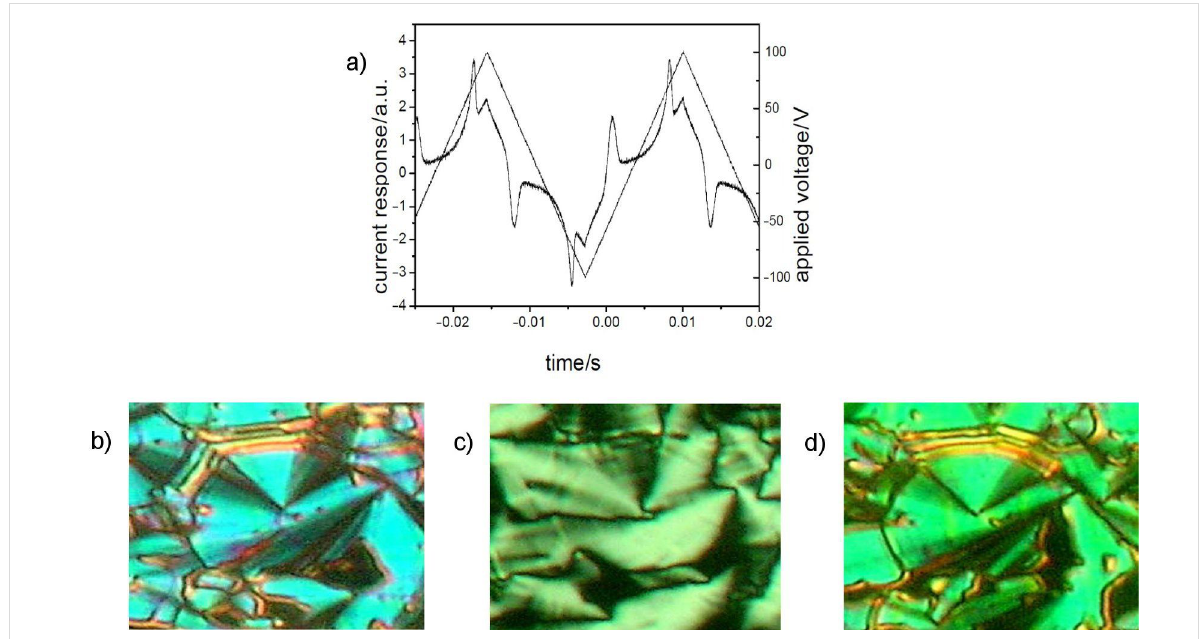
Figure 25: Electro-optical behaviour of compound OH 6c : a) Current response ( U A.C. = 17 V/µm, f = 39 Hz, T = 123 °C, d cell = 6 μ m, P S = 520 nC/cm 2 ); c) 0 V, ground state SmC a P A ; b) and d) formation of the SmC s P F phase upon application of a D.C. field of different sign: b) +7 V/µm; d) − 7